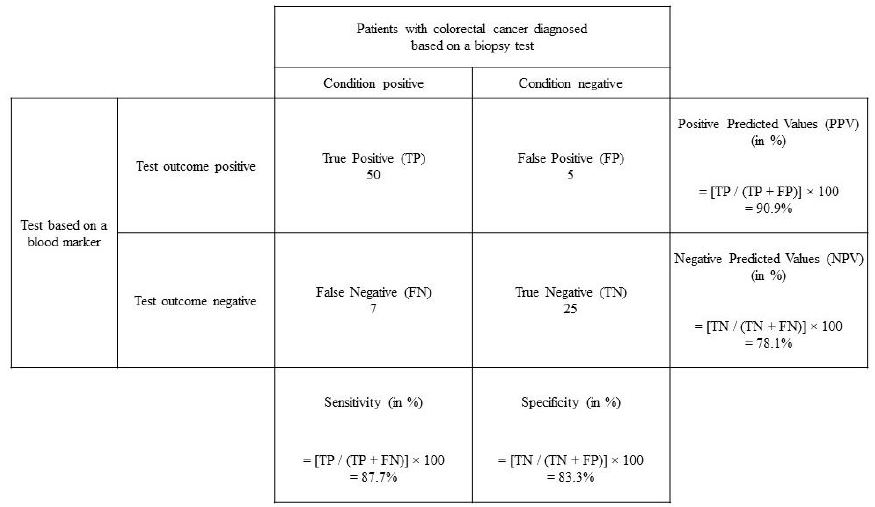
Figure 1. Four possible scenarios in diagnostic research.